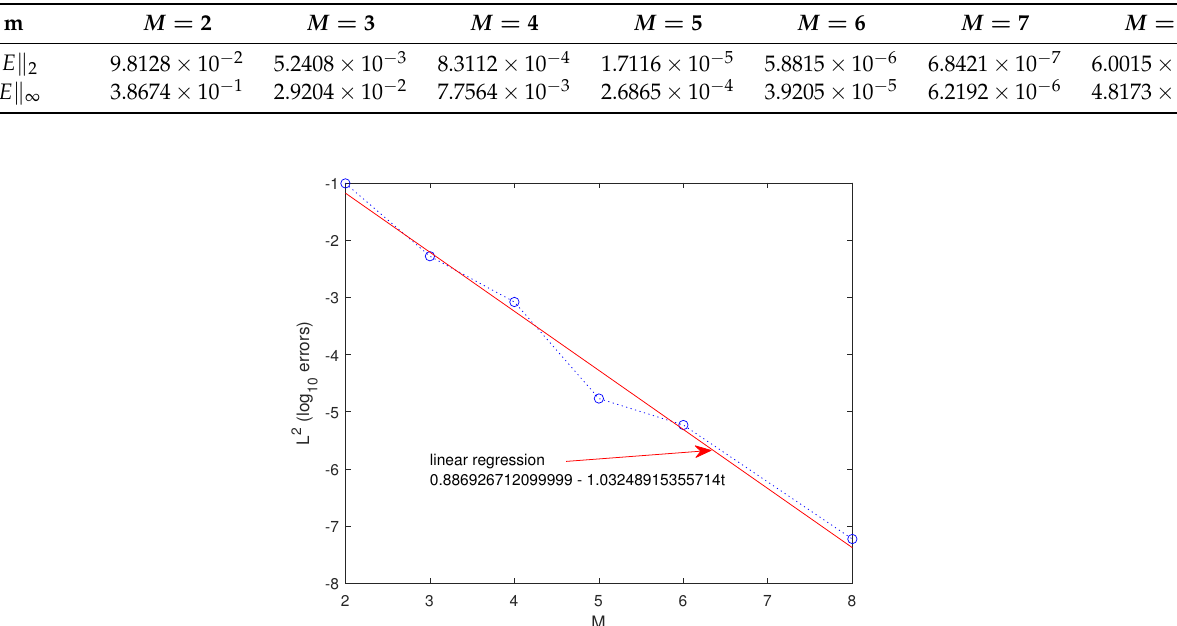
Figure 3. Plot of the log ( L 2 errors ) and the linear regression for Example 3.